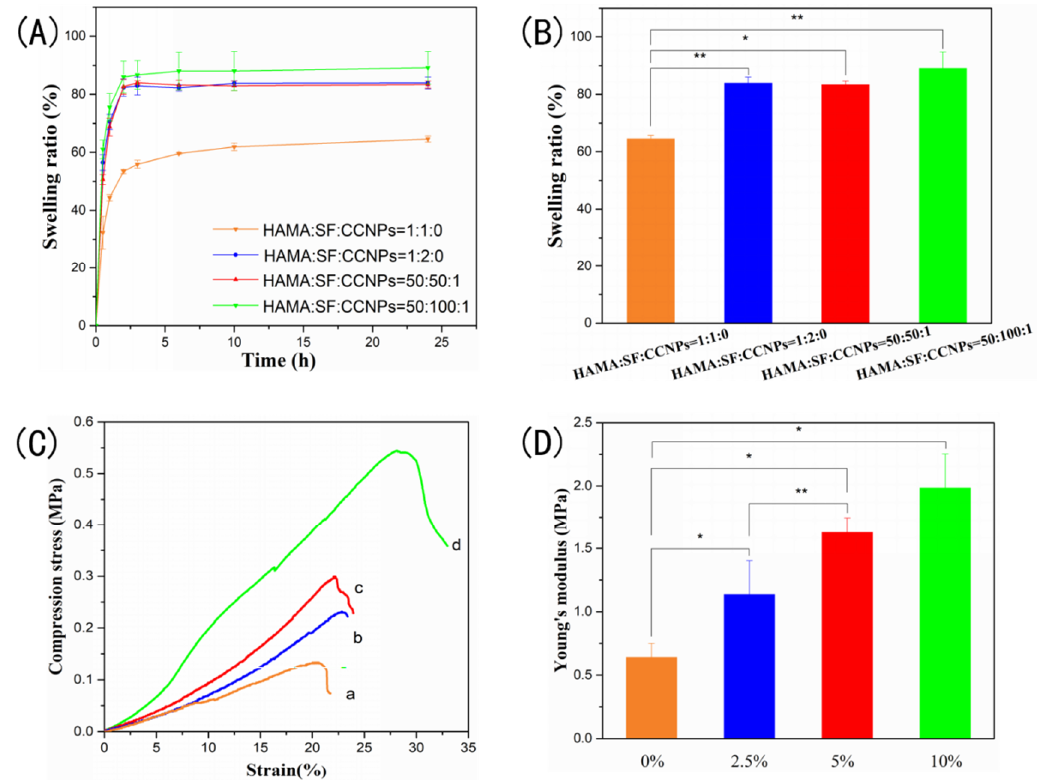
Figure 6. Swelling ratio curve ( A ) and swelling ratio ( B ) of CCNPs-SF/HAMA hydrogels, stress-strain curve and Young’s modulus of CCNPs-SF/HAMA hydrogels with different concentrations (0% (a), 2.5% (b), 5% (c), 10% (d)) of SF ( C , D ). Data are expressed as mean ± SD ( n = 4); * p < 0.05, and ** p < 0.01 are differences between the indicated groups.